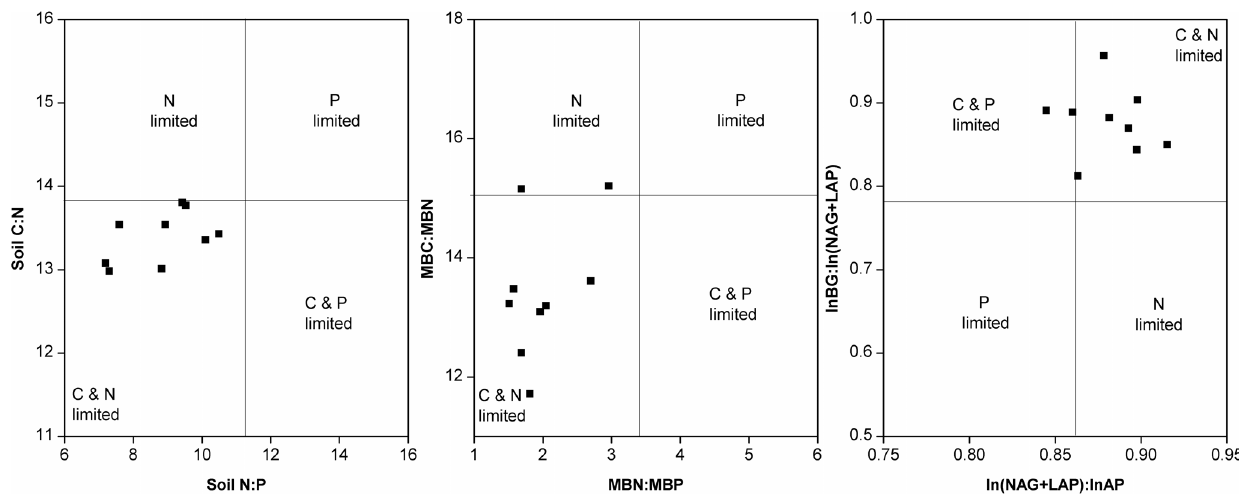
Figure 4. Scatter plots of C:N:P stoichiometry for soil chemistry, microbial biomass, and eco-enzymatic activities for the paddy system under P application compared to P-0.